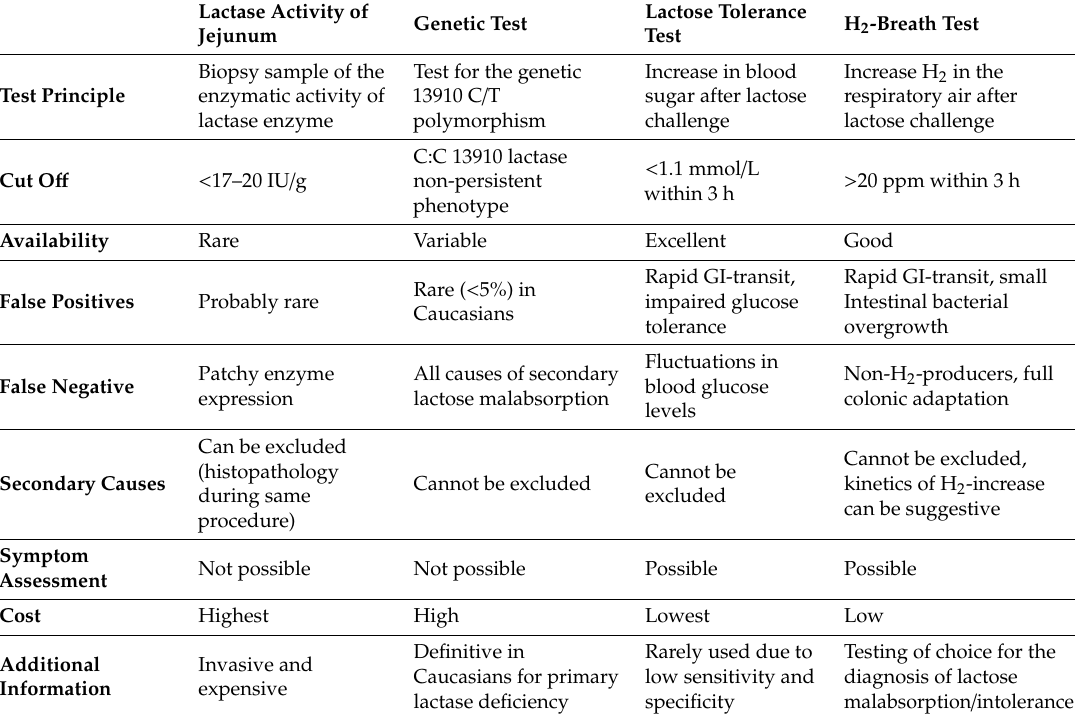
Table 1. Di ff erences and similarities between the tests that are currently used for detecting lactose malabsorption / lactose intolerance (modified from